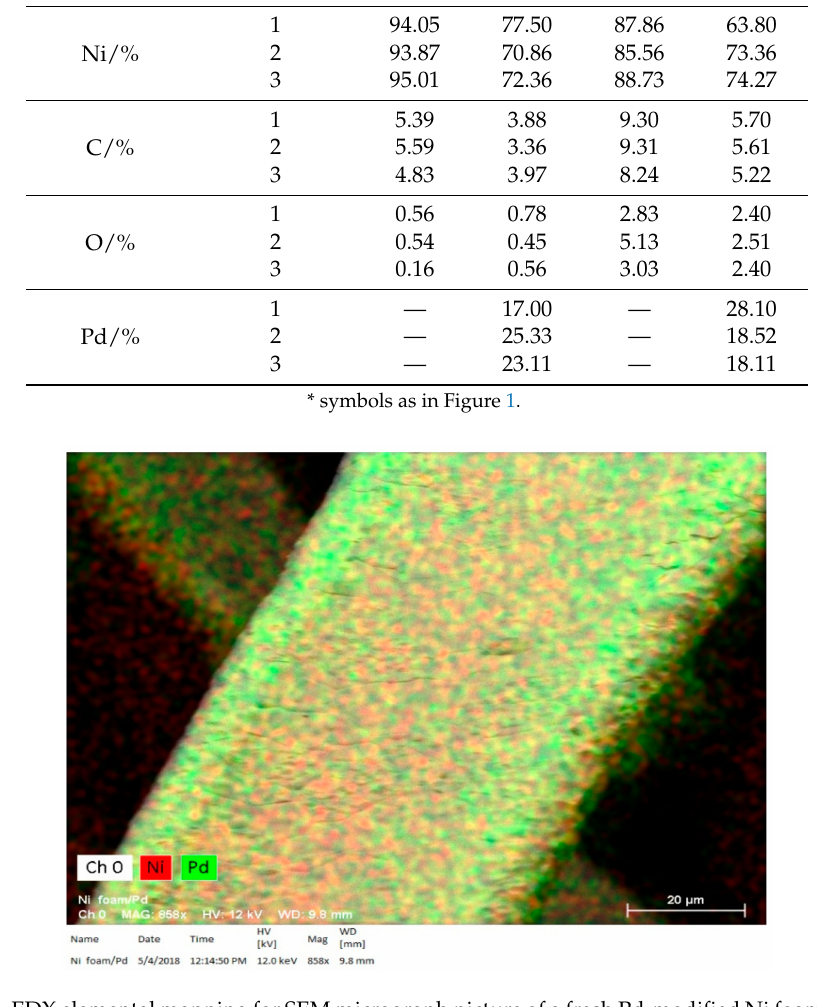
Figure 2. EDX elemental mapping for SEM micrograph picture of a fresh Pd-modified Ni foam electrode taken at 858 × magnification, an acceleration voltage of 12 kV and the working distance of 9.8